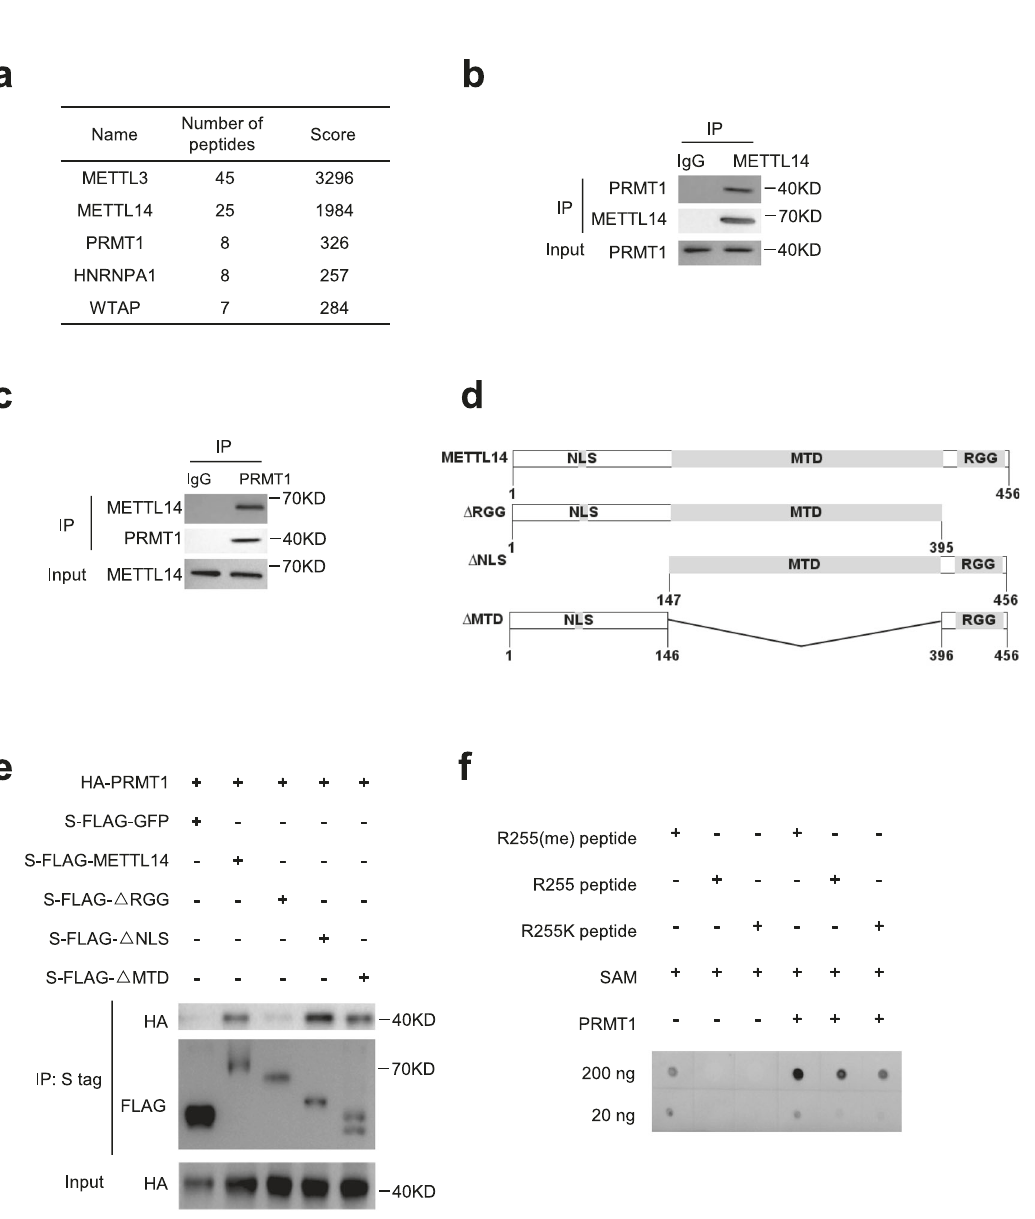
Fig. 3 PRMT1 physically interacts with and methylates METTL14. a List of the fi ve most abundant proteins identi fi ed in the tandem af fi nity puri fi cation (TAP) pull down assay with METTL14 identi fi ed by LC – MS/MS using Mascot search engine in HeLa cells. b – c Co-IP of endogenous METTL14 ( b ) and PRMT1 ( c ) in HeLa cells. d Schematic of METTL14 truncations. MTD methyltransferase domain, NLS nuclear localization signal, RGG RGG repeats. e Western blot showing interactions of PRMT1 and ectopically expressed full-length or truncated METTL14 in HeLa cells. Representative fi gures of three independent replicates are shown. f In vitro methylation of R255me, R255, and R255K peptides by PRMT1. Representative fi gures of two independent replicates are shown. SAM S-Adenosyl-L-Methionine. Source data for ( b ), ( c ), ( e ) and ( f ) are provided as a Source Data fi le. NATURE COMMUNICATIONS| (2021) 12:3780 |https://doi.org/10.1038/s41467-021-24035-6|www.nature.com/naturecommunications